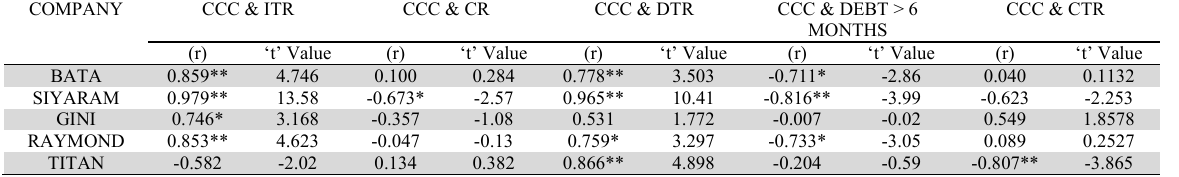
Karl Pearson’s Simple Correlation Analysis between CCC and ITR, CR, DTR, Debt > 6 Months